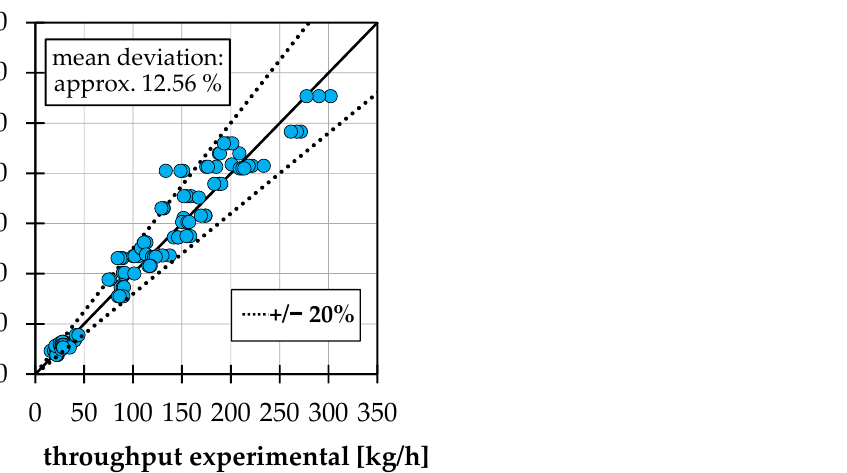
Figure 14. Comparison of experimental throughput with analytical calculation (without use of correction factor for conveying case 2a).